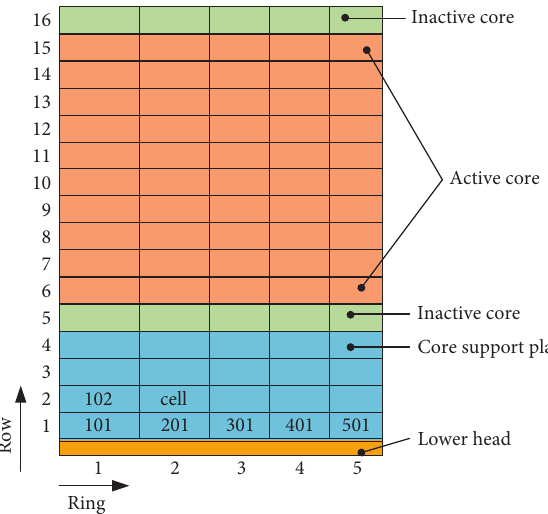
Figure 2: Nodalization of the core of the marine